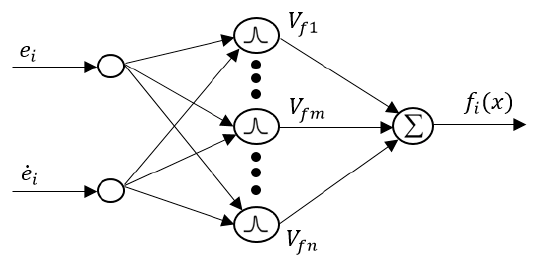
Figure 3. Structure of radial basis function (RBF) neural network.